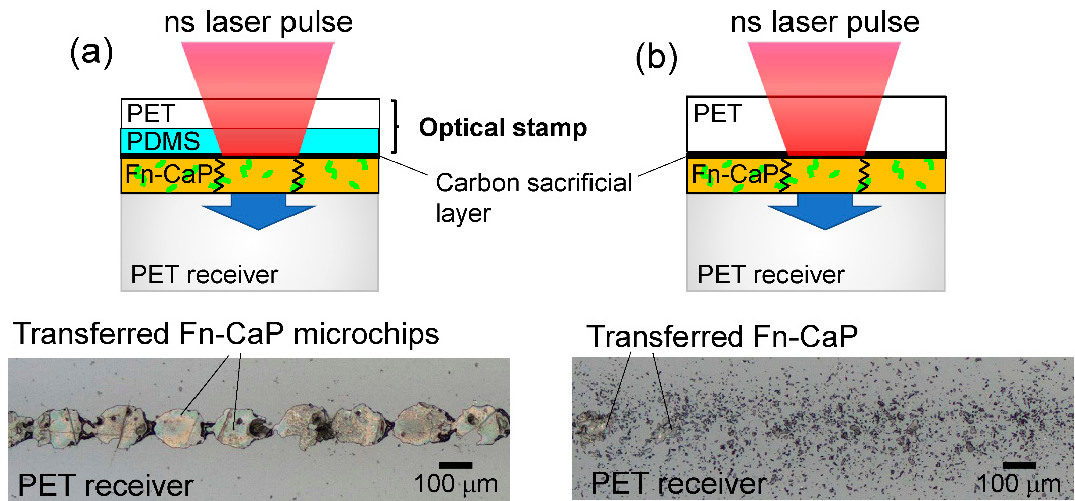
Figure 3. ( a ) Schematic image of the LIFTOP process (upper) and a confocal laser scanning microscopic image of the Fn-CaP microchips transferred onto the PET receiver substrate by the LIFTOP process (lower). For comparison, the Fn-CaP film was transferred by the laser-induced forward transfer process without the optical stamp, as shown in ( b ).